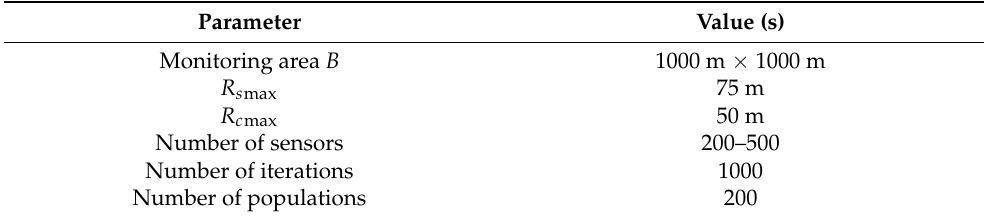
Table 3. Simulation Parameters with respect to area B.